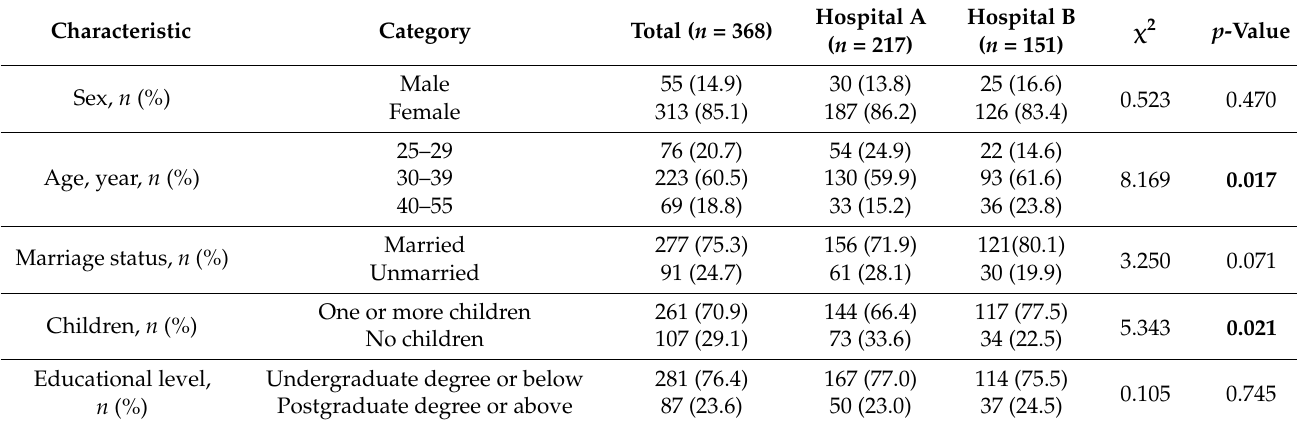
Table 1. Demographic characteristics of Hospital A and Hospital